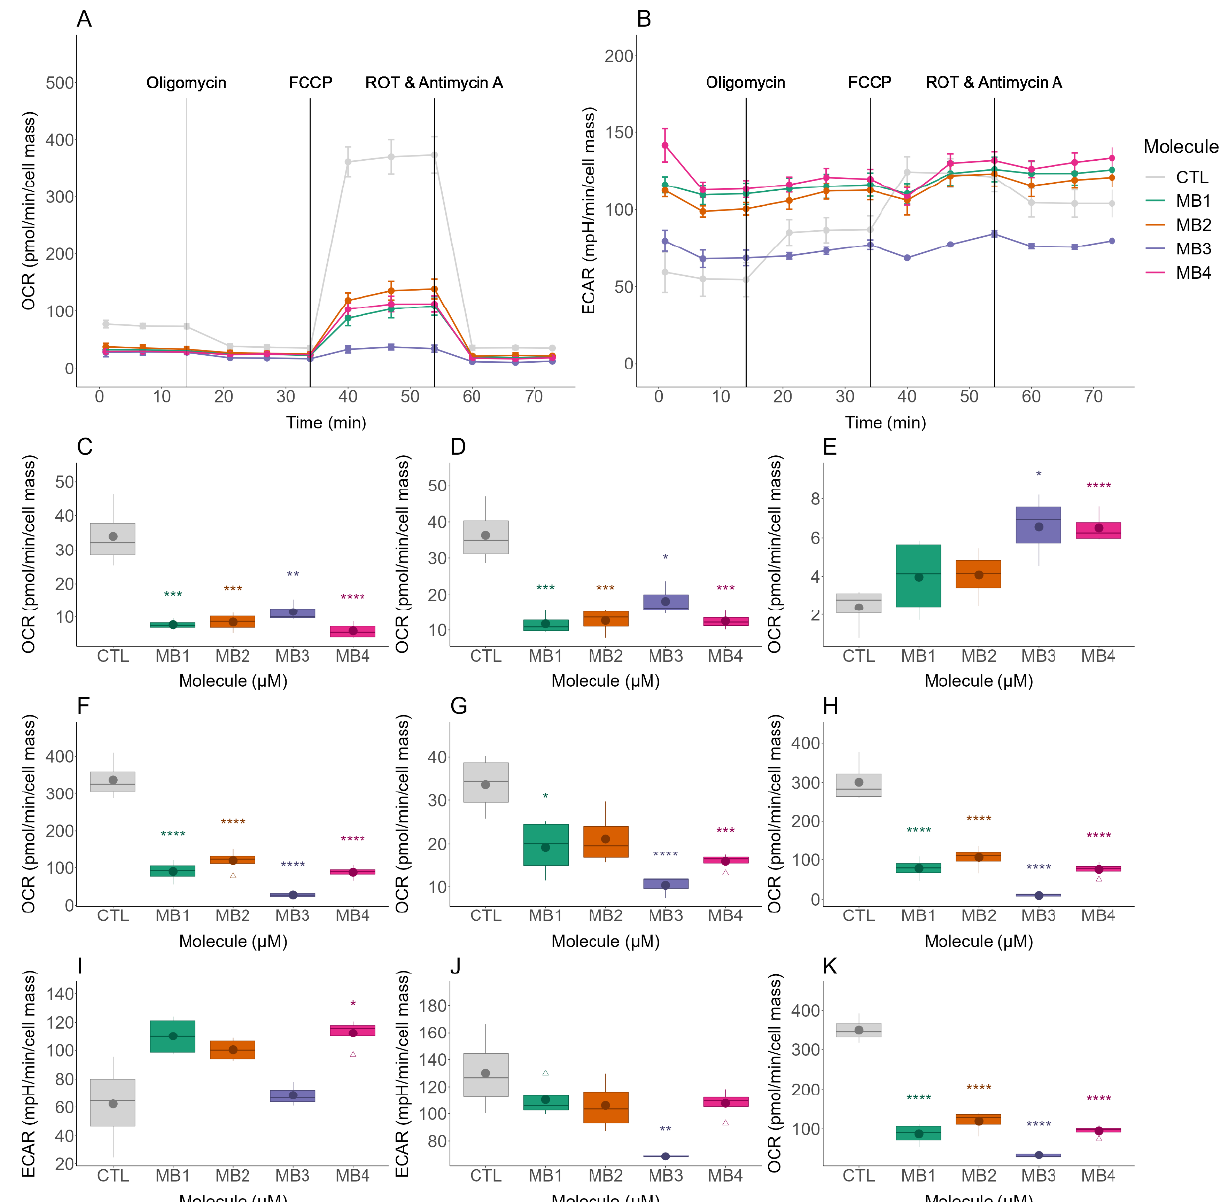
Figure 5. Effects of hydroxybenzoic-based mitochondriotropic antioxidants MB1-MB4 on oxygen consumption rate (OCR) and extracellular acidification rate (ECAR). OCR- and ECAR-associated parameters were assessed with a Seahorse XFe96 Extracellular Flux Analyzer. OCRs ( A ) and ECARs ( B ) were assessed in normal human dermal fibroblast (NHDF) cells treated with MB1, MB2, and MB4 at 25 μM and MB3 at 6.3 μM for 48 h. Several OCR parameters were evaluated: ATP production-linked OCR ( C ), basal respiration ( D ), proton leak-based OCR ( E ), maximal respiration ( F ), non-mitochondrial respiration ( G ) and spare respiratory capacity ( H ). ECAR parameters were also evaluated, including basal ECAR ( I ), stressed ECAR ( J ), and stressed OCR ( K ). Data are the mean ± SE of three independent experiments and the results are expressed in the interquartile range (Q1–Q3) together with the (−) median. Statistically significant differences between control (CTL) and treated groups were evaluated using a t -test. **** p < 0.0001, *** p < 0.001, ** p < 0.01 and * p < 0.05 compared to the respective CTL (vehicle-treated cells).